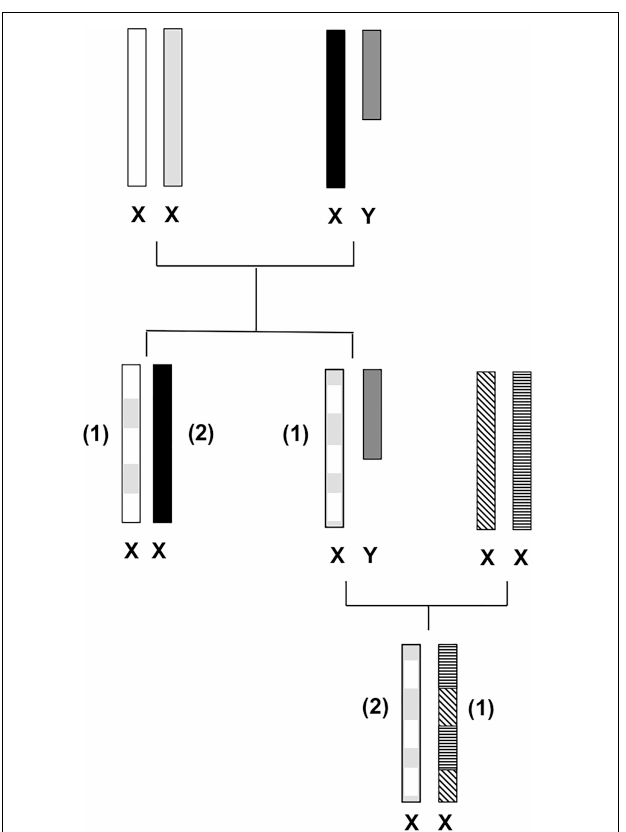
FIGURE 1 | X-chromosomal inheritance. Female and male descendants inherit a recombined maternal X chromosome (1) that resulted from female meiosis. Female offspring inherit one paternal unchanged X chromosome (2) due to lack of recombination [with exception for the pseudoautosomal region (PAR)